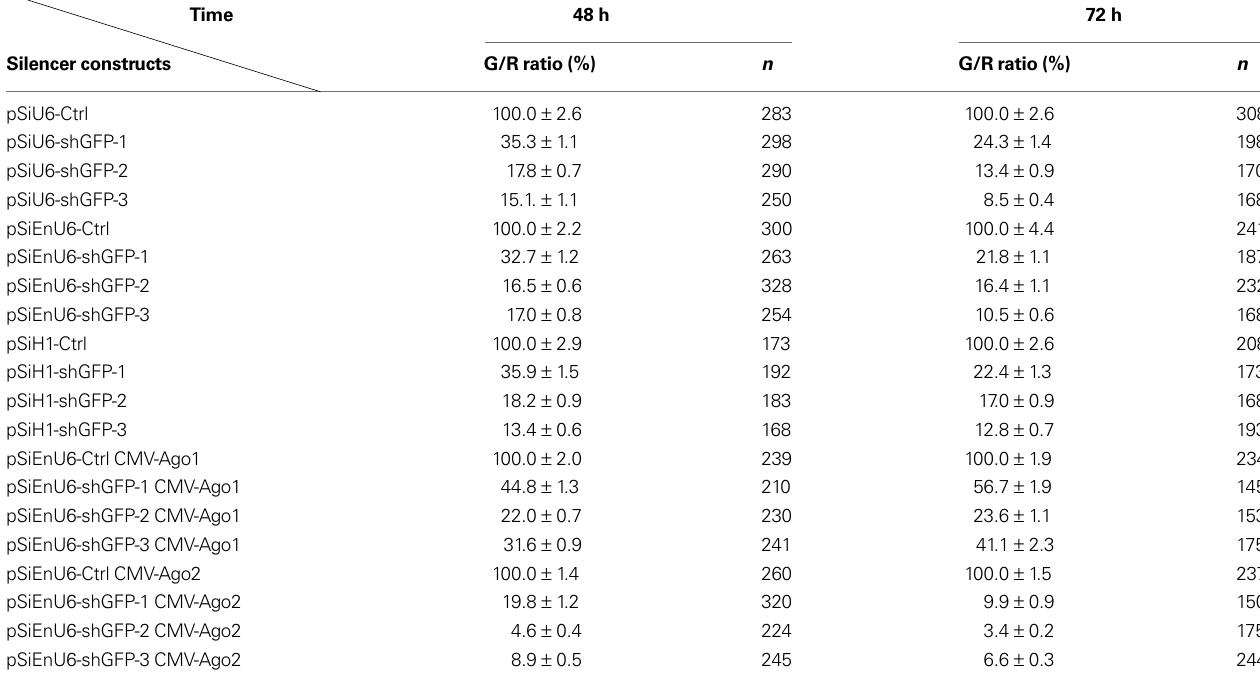
Table 1 | Effect of RNAi with different silencer constructs in HEK293 cells.